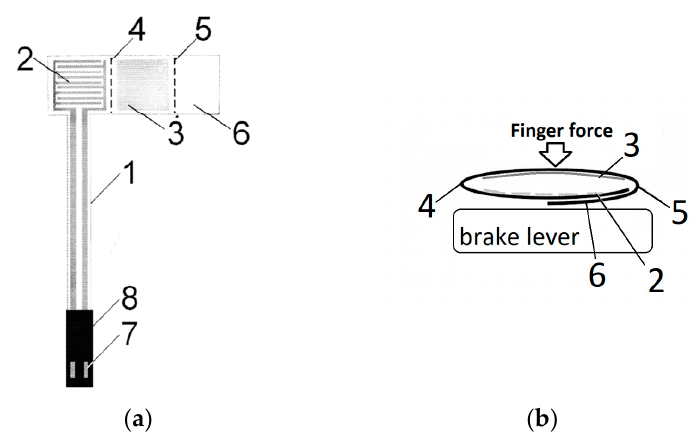
Figure 5. The schematic drawing of a folic tactile sensor ( a ) PL 222119.B1, where: 1—conductive tracks on the base layer, 2—electrodes, 3—jumper, 4—bending edge between electrodes and jumper, 5—bending edge between jumper and passive element, 6—passive element, 7—connector, 8—PCV connector housing, and ready to use sensor in current study setup ( b ) (author’s material).